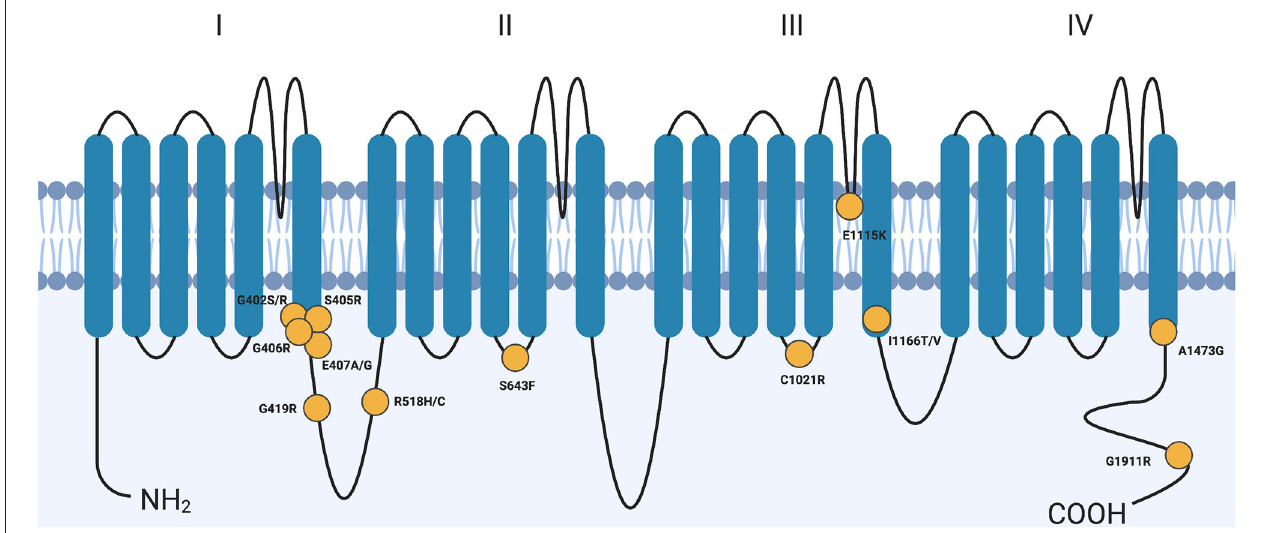
FIGURE 1 | Variants across CACNA1C cause Timothy syndrome. CACNA1C is a 24-transmembrane-pass channel that consists of four repeats (I–IV) of 6 transmembrane segments (SI-S6). Yellow circles denote approximate locations of TS-causing variants. Though G406R is only shown once, it does represent two distinct mutations, one in mutually exclusive exon 8 or exon 8A. G, Glycine; R, Arginine; S, Serine; E, Glutamate; A, Alanine; C, Cysteine; H, Histidine; F, Phenylalanine; K, Lysine; I, Isoleucine; T, Threonine; V, Valine. Created with